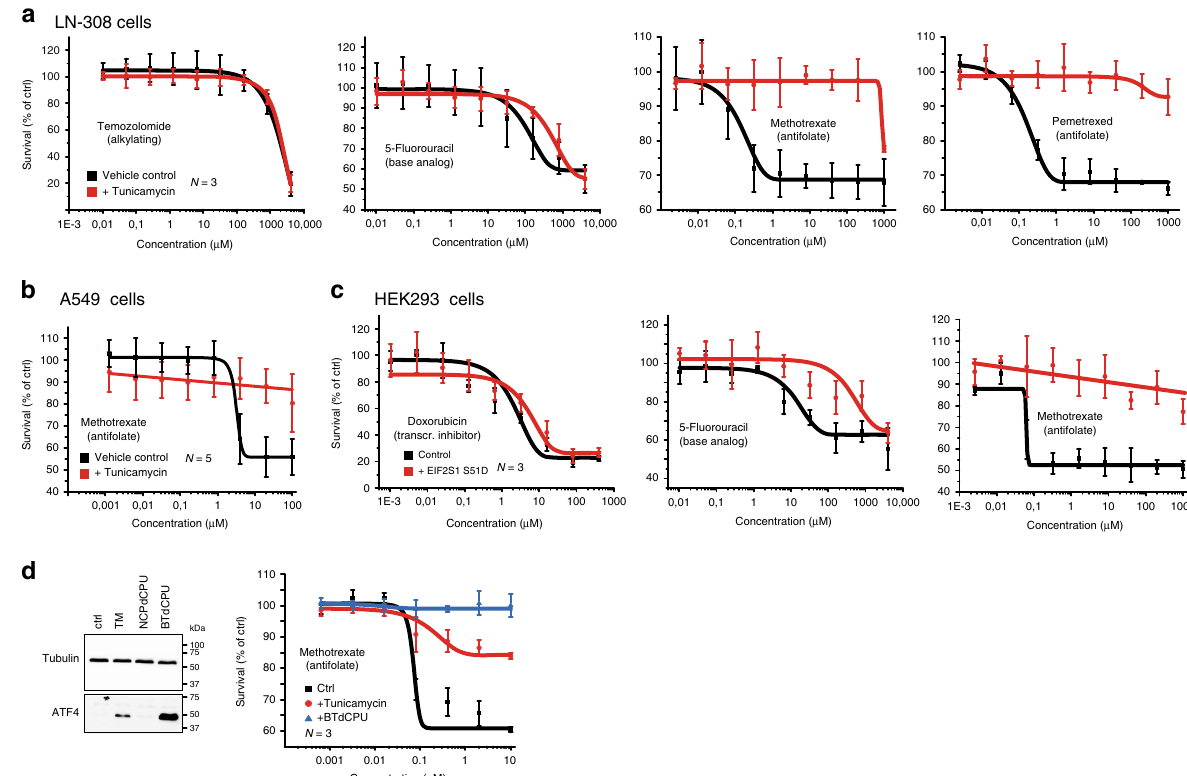
Fig. 6 Stress-mediated phosphorylation of EIF2S1 induces resistance to the folate-based antimetabolites methotrexate and pemetrexed. Survival of LN-308 cells ( a ) and A459 cells ( b ) after 24 h of treatment with the indicated concentrations of the FDA-approved chemotherapeutic reagents in the absence (black lines, vehicle control) or presence of tunicamycin (red lines). c Survival of stably transfected HEK293 cells before (black lines, vehicle control) and after induction of expression of a phosphomimetic mutant of EIF2S1 (S51D) (red lines). Cells were treated for 24 h with the indicated concentrations of FDA-approved chemotherapeutic reagents before scoring survival. d Survival of LN-308 cells in the presence of MTX after activation of the kinase HRI. Left panel: representative western blots of ATF4 and beta-tubulin protein levels after stimulation with the HRI activator BTdCPU, or the control compound NCPdCPU. Treatment with DMSO or TM served as control. Right panel: Cell survival in the presence of the indicated concentrations of MTX of control-treated LN-308 cells (black), TM-treated (red), or BTdCPU-treated LN-308 cells (blue). Data are represented as mean ± SD of three ( a , c , and d ) or fi ve ( b ) biologically independent experiments. Representative western blots of at least three biologically independent replicates are depicted; pictures of the uncropped membranes are provided in the supplementary